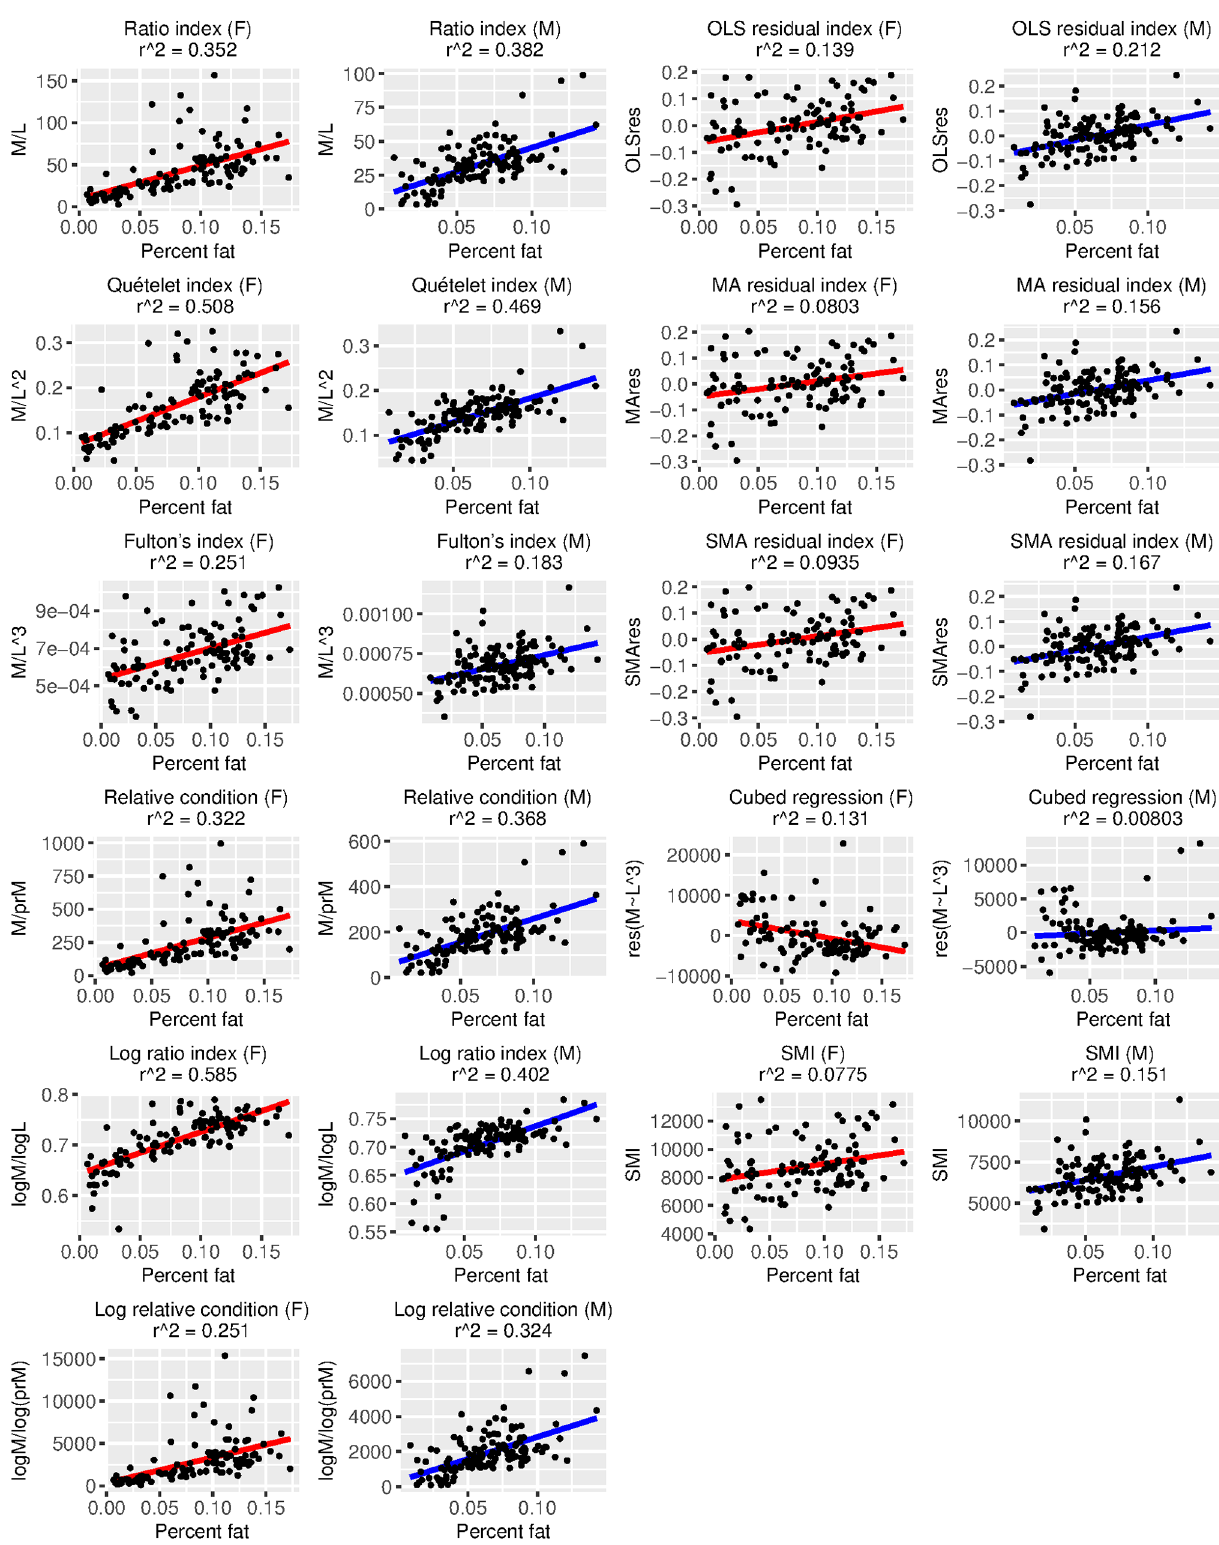
Fig 2. Relationships between 11 body condition indices (BCIs) and percent fat, a measureof true body condition, for each sex. Variationin each BCI that can be explained by percent fat is providedas an r 2 value. Ideally, most variationin a BCI should be attributable to